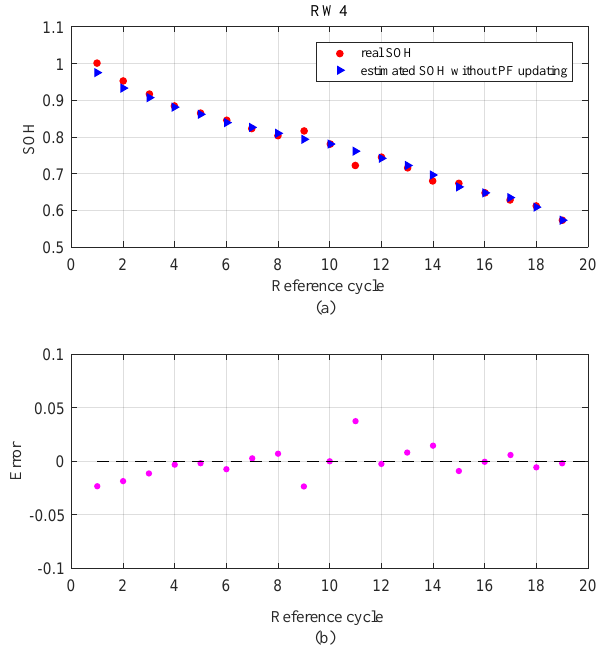
Figure 14. ( a ) SOH estimation results and ( b ) estimation errors for battery RW4 using indirect HIs without PF